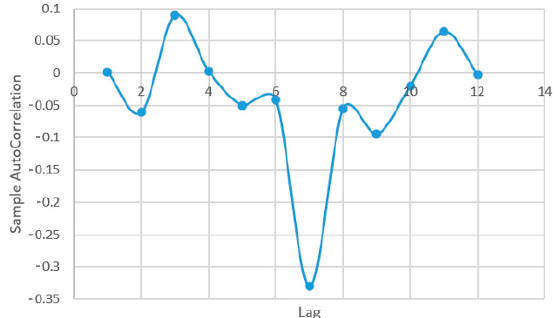
Figure A5. The AC with transformation in square roots—AH series.